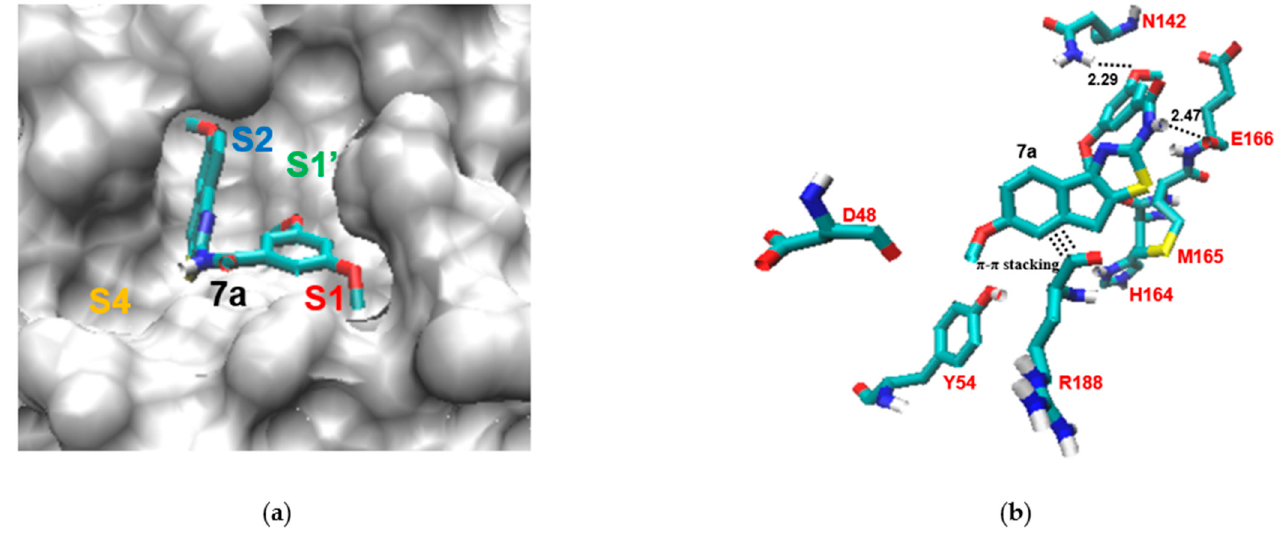
Figure 3. ( a ) surf representation of the compound 7a (bonds representation ) in the 3CL pro S1 (red), S2 (blue), S1 ′ (green), S4 (orange) binding pocket; ( b ) the docking results of 7a and 3CL pro (PDB code: 6M2N, active residues in 3.0 Å range around 7a ).